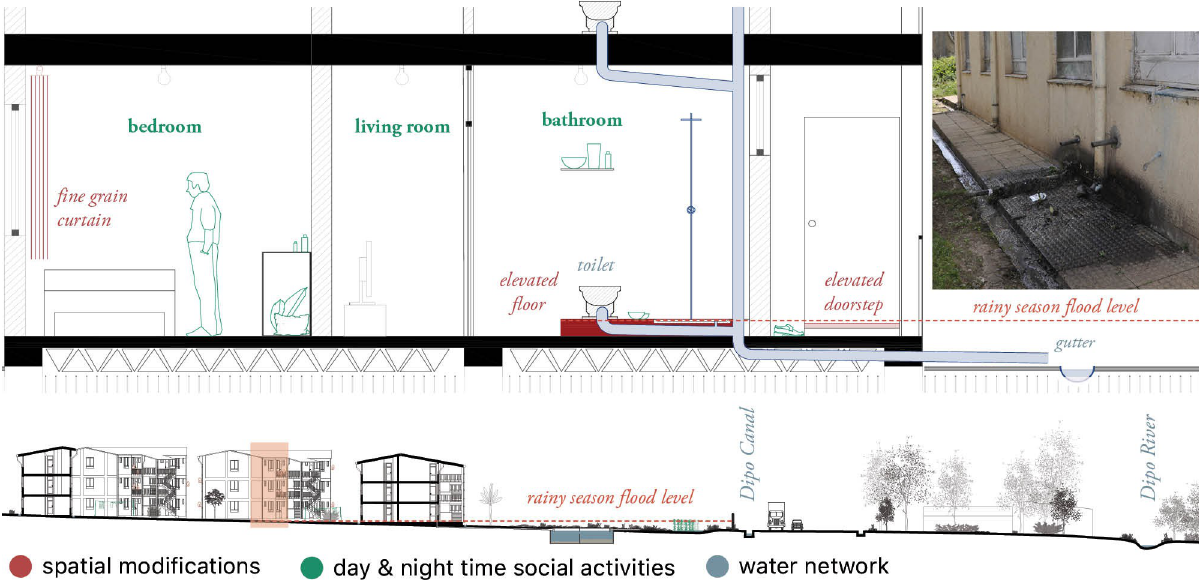
Fig 7. Artificial water networks in Condominium D. Detail of a typical altered plumbing pipes and ditch. Blocking of the original grey and black water networks leads to self-made solutions shortcutting on the original system. Black and grey water flow directly into the surrounding ditches.